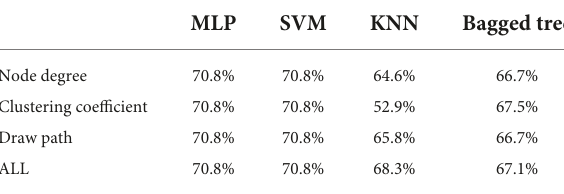
TABLE 2 Binary classification emotion recognition results based on arousal.